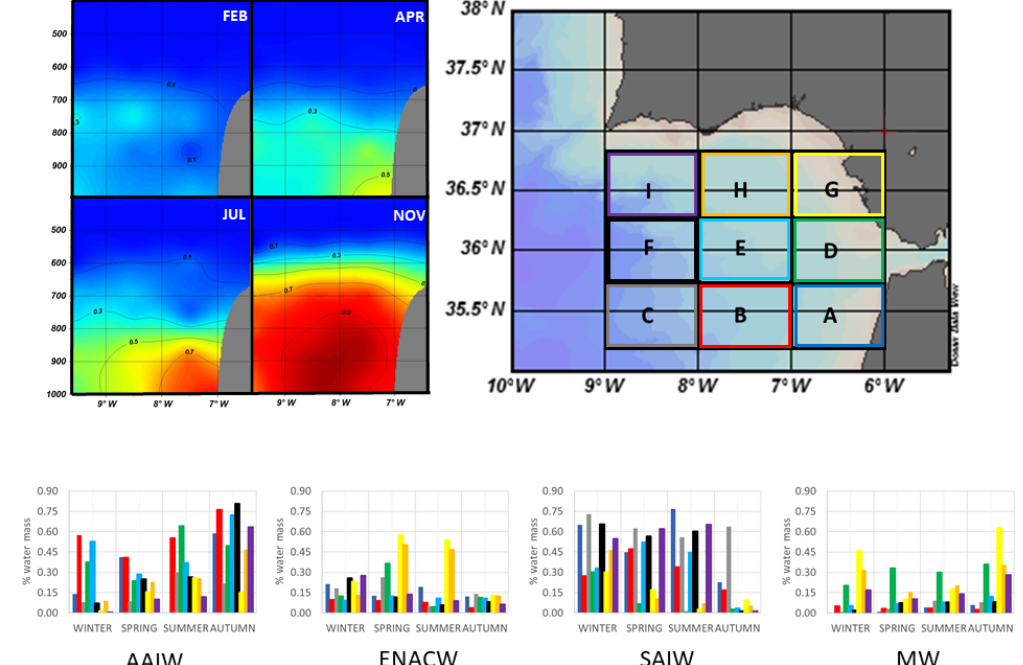
Figure 6. Values of percentages of each water mass resulting from the OMP analysis in each of the boxes shown in the map in the bottom right-hand corner, for each season. In the bottom left-hand corner, the resulting percentages are shown from the OMP analysis applied on the WOA database for a zonal section at 36 ◦ N in selected climatological months. The data selected for OMP analysis are those in the depth range of